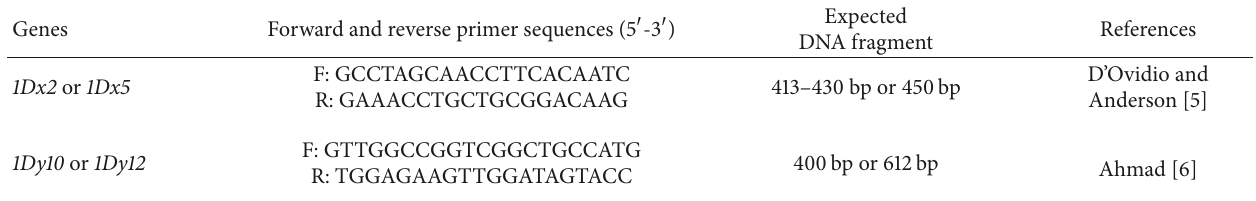
Table 1: Sets of alleles: specific markers for the identification of wheat HMW glutenin genes used in the study. Genes